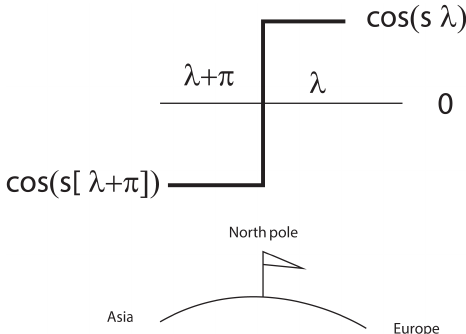
Figure C2. Schematic of the behavior of a s (ϕ) cos (sλ) along a meridian. If a s ( 0 ) (cid:54)= 0, the Fourier term will have a jump discontinuity across the pole (thick black curve) when longitude jumps by π